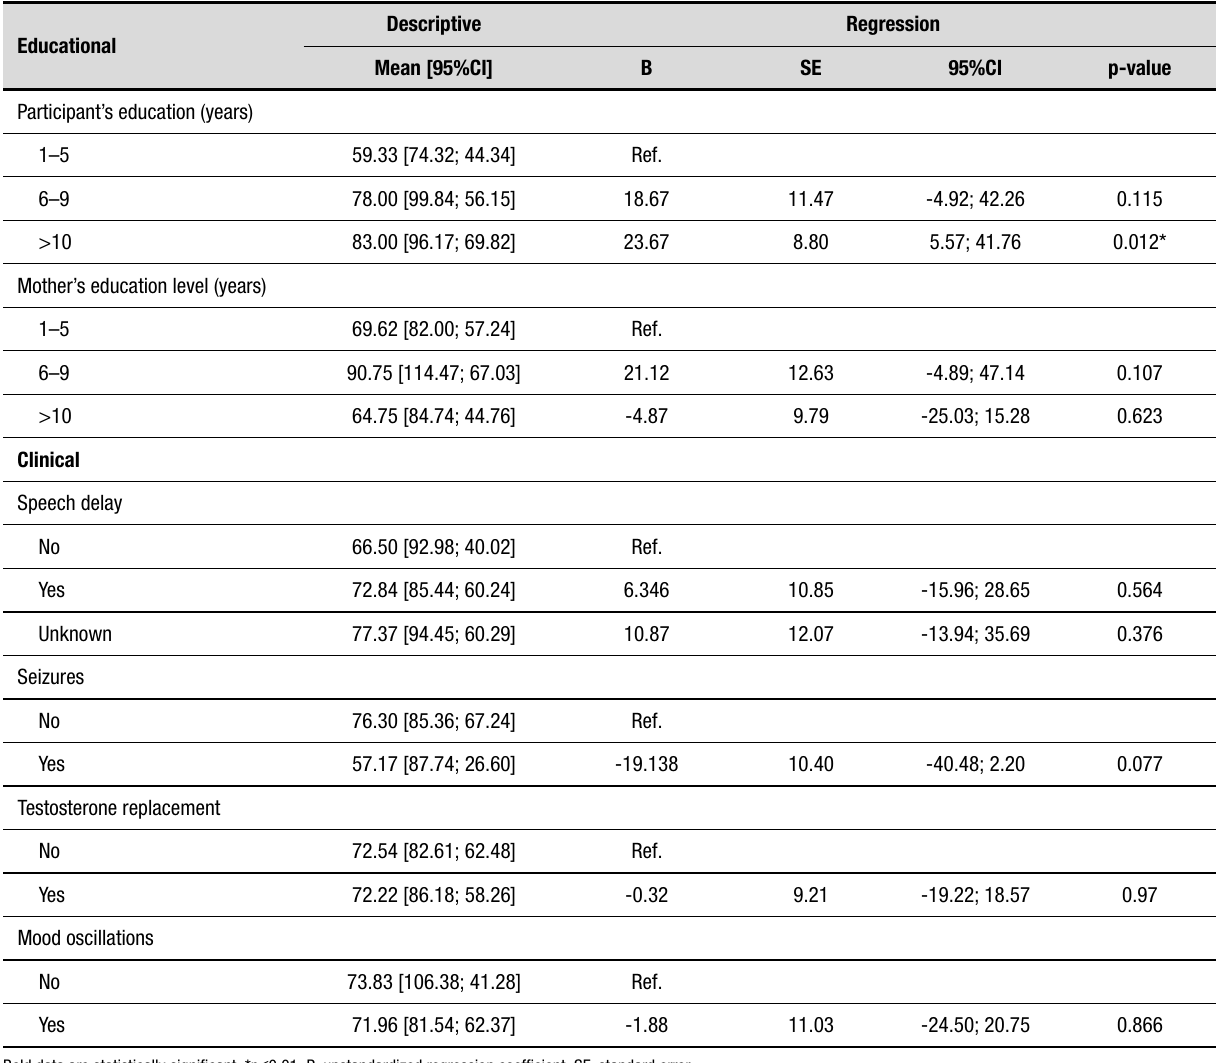
Table 4. Linear regression applying educational level and clinical variables for predicting adaptive behavior in Klinefelter syndrome cohort. Descriptive Educational